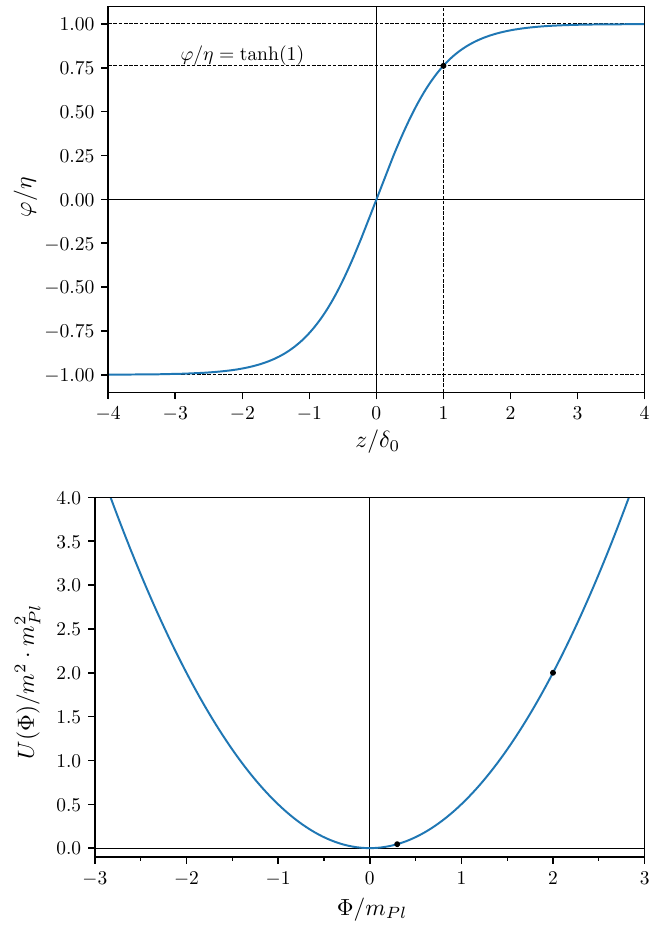
Fig. 1 Domain wall in flat space-time